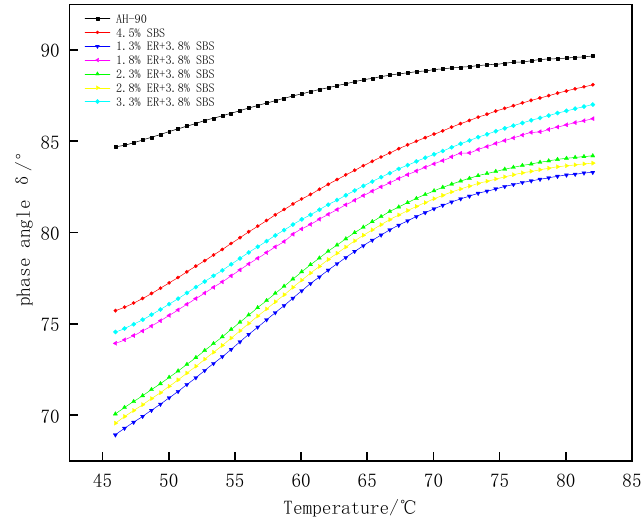
Figure 11. Effect of temperature on the complex phase angle of ER/SBS modified bitumen.